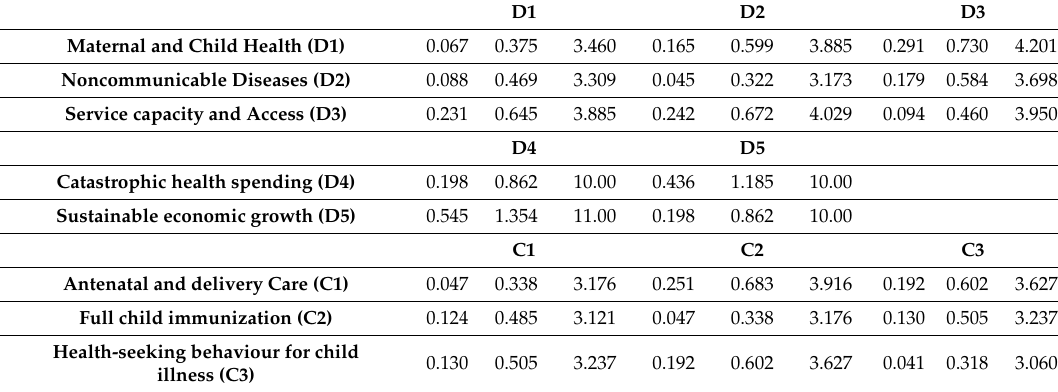
Table A3. Total-relation fuzzy